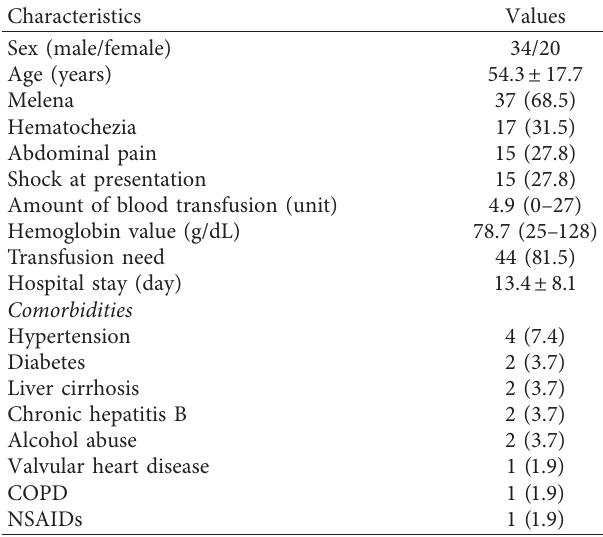
Table 1: Clinical features of patients with small bowel